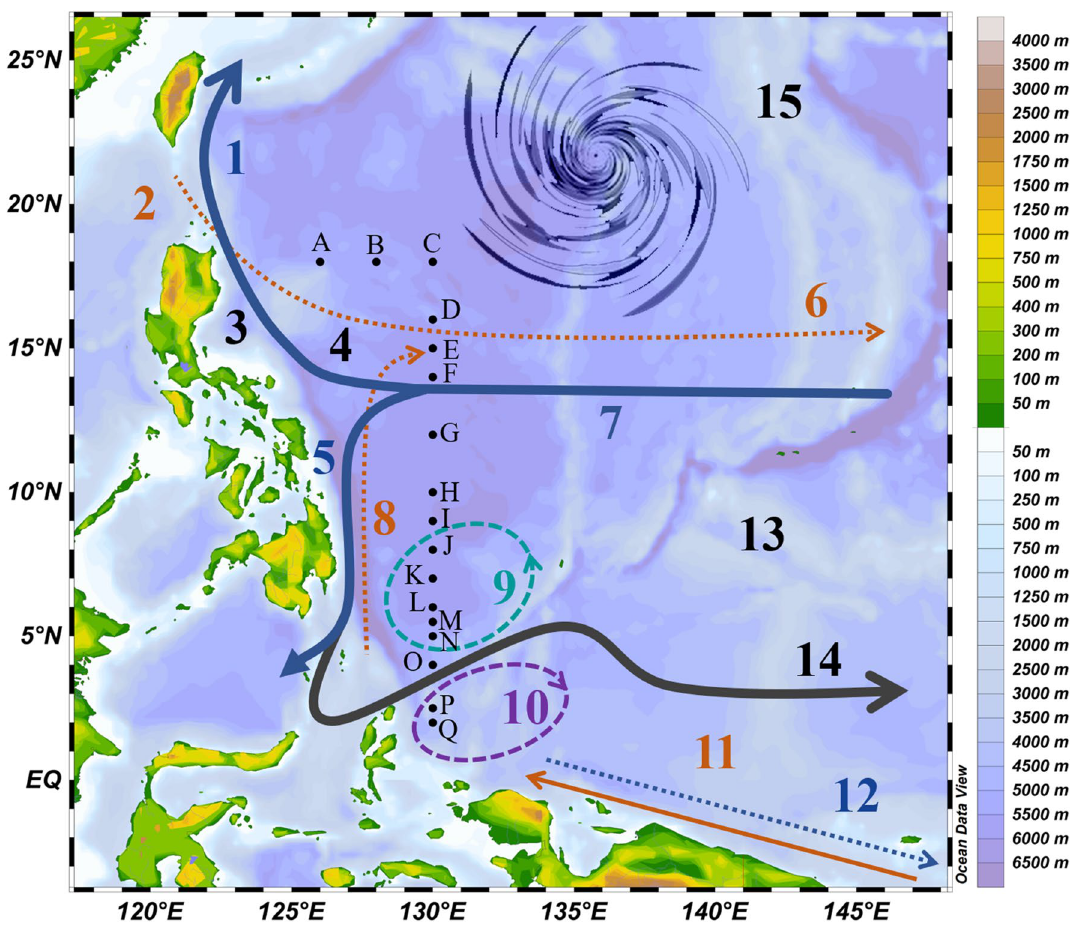
Figure 1. Sampling stations (St. A–Q) with different local currents (A), i.e., 7 = North Equatorial current (NEC), 6 = North Equatorial under current (NEUC), 14 = North Equatorial counter current (NECC), 1 = Kuroshio current (KC), 2 = Luzon Under current (LUC), 5 = Mindanao current (MC), 8 = Mindanao under current (MUC), 11 = New Guinea coastal current (NGCC), and 12 = New Guinea coastal under current (NGCUC), with the related geo-physical forcings, i.e., 9 = Mindanao Eddy (ME), 10 = Halmahera Eddy (HE), 3 = Philippine trenches (PT) in the Western Pacific Ocean (WPO). Additionally, Typhoon Lan 45 occurred near the Philippine coast during the sampling period in the WPO